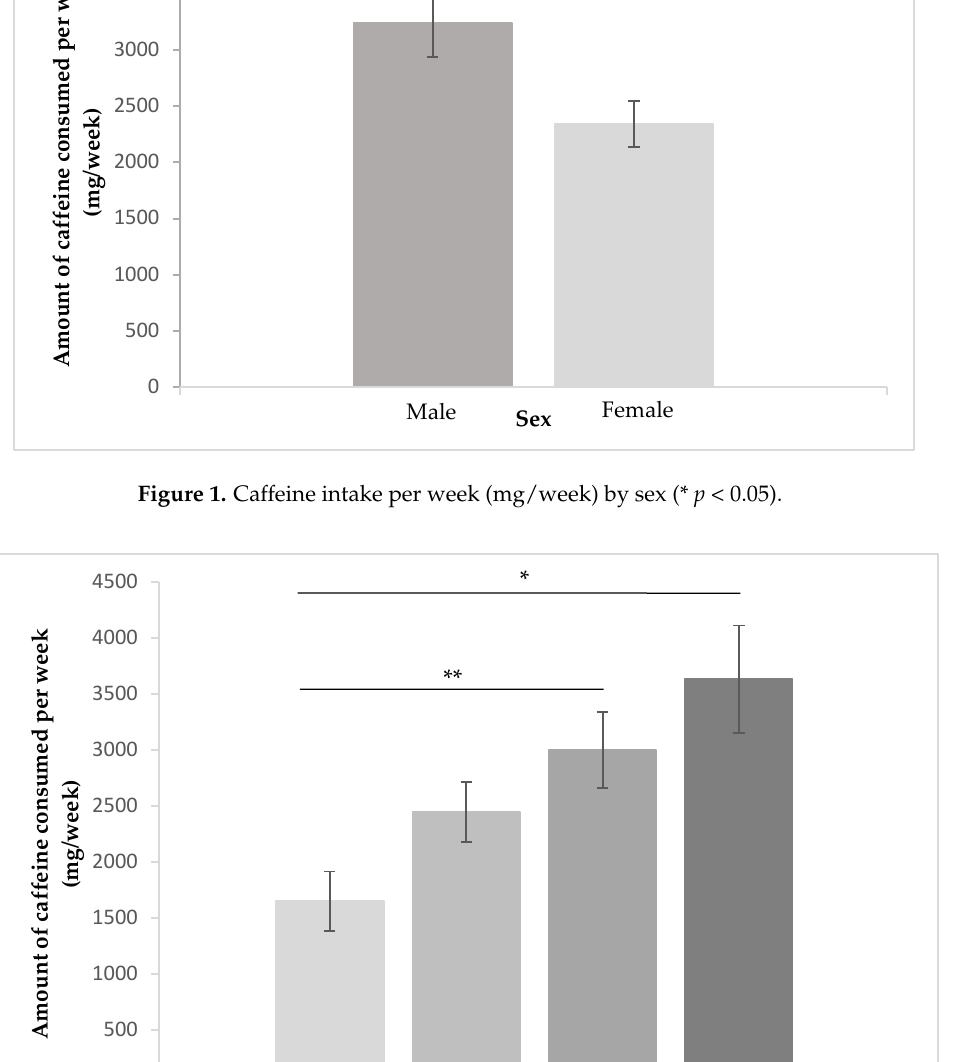
Figure 2. Caffeine intake per week (mg/week) by age groups (years) ( *p < 0.05; ** p < 0.01). Considering coffee consumption by sex and age, it was found that older males (30–35 age group) reported consuming more caffeine than the other age groups ( M = 4791.04, SD = 2856.97). Moreover, older females also had the highest consumption ( M = 2892.29, SD = 2691.42) compared to the other age groups. In addition, statistically significant differ- ences were found between the different age groups within each sex, as demonstrated by the Kruskal–Wallis H tests for males and females ( χ 2 (3) = 8.02, p = 0.046; χ 2 (3) = 9.99, p = 0.019, respectively), followed again by Dunn’s multiple comparisons post hoc test including all six pairs of groups for each sex, showing a significant difference in the average amount of caffeine consumption between older males and the 22–25 age group ( p = 0.029), and younger females (18–21) and the 26–29 age group ( p =